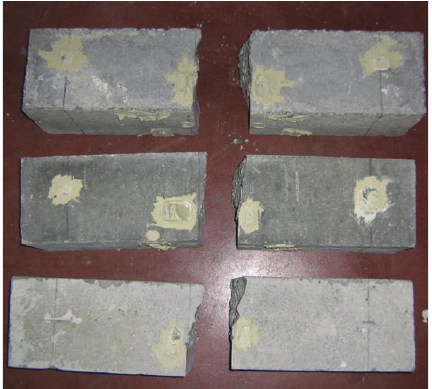
Figure 6: Post-test aspect of the notched specimens without fibres.